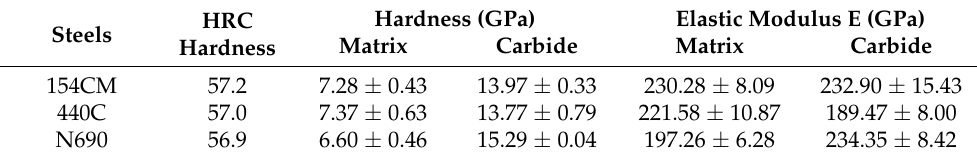
Table 3. Hardness and elastic modulus of martensitic stainless steel from indentation